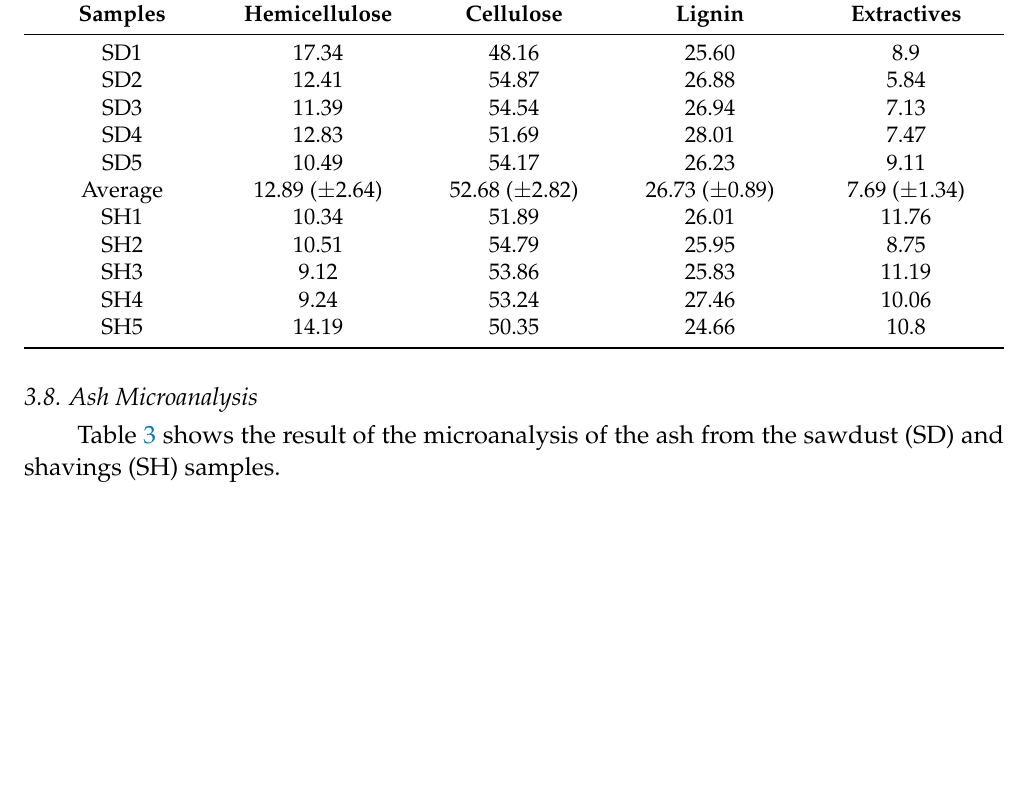
Table 2. Basic chemical composition of sawdust (SD) and shavings (SH) samples (%).